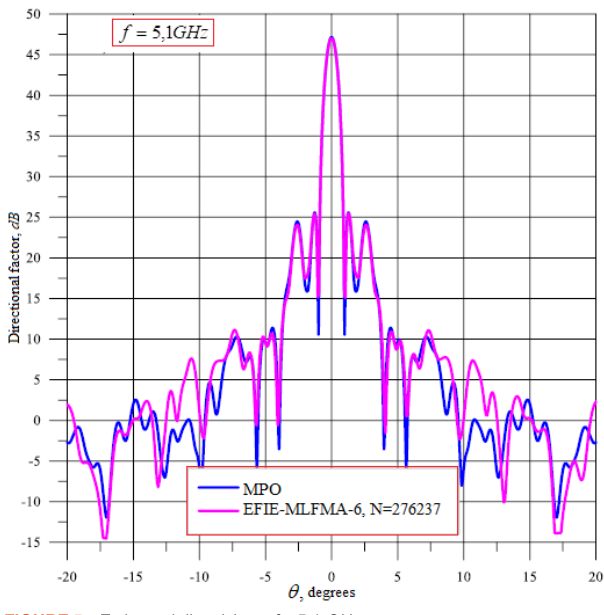
FIGURE 5. Estimated directivity at f = 5,1 GHz .